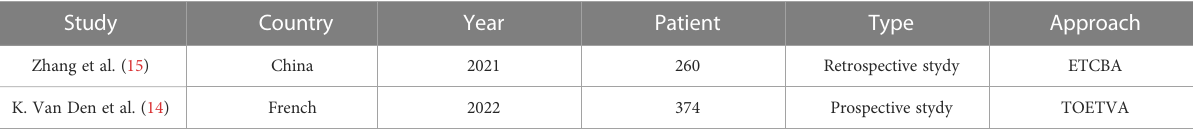
TABLE 1 The details of two endoscopic